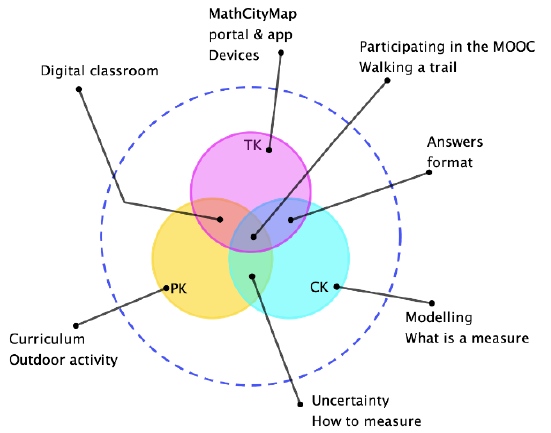
Figure 18. Nodes of knowledge strengthened by participation, from the TPACK